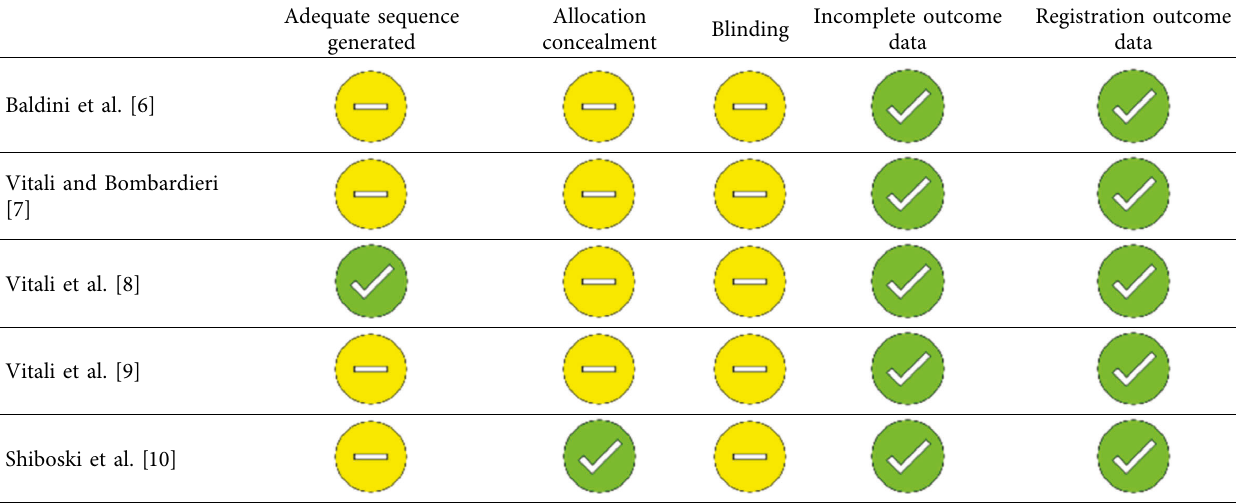
Figure 1: Flow chart of the systematic review process. Table 1: The risk of bias in studies is represented by the green symbol, low risk of bias, and the yellow symbol, high risk of